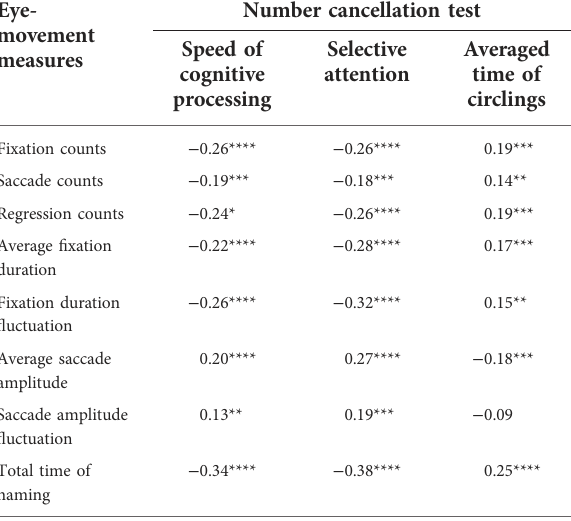
TABLE 5 Correlation between number-cancellation-related skills and eye-movement measures in task N-object. Eye-